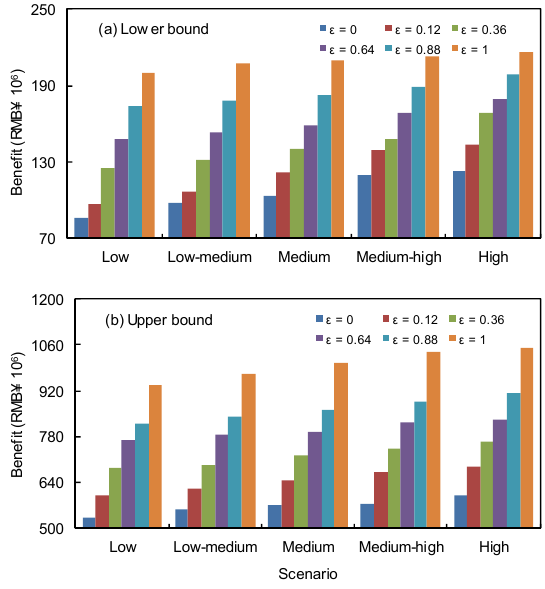
Figure 4. Benefit corresponding to each scenario and risk level. ( a ) Lower bound and ( b ) Upper bound.